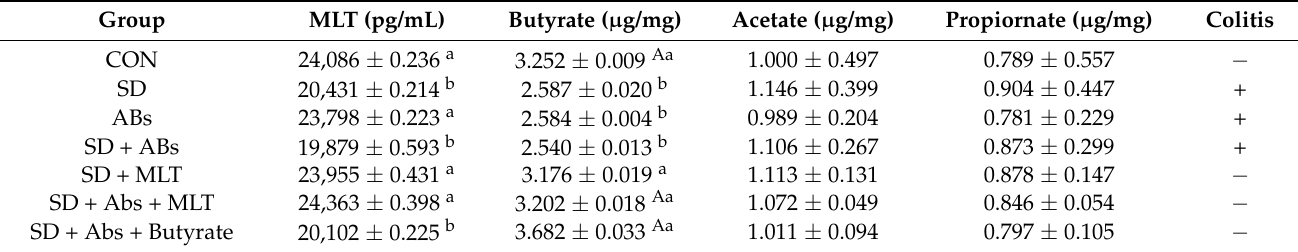
Table 1. Changes in plasma melatonin level and colonic SCFAs production in